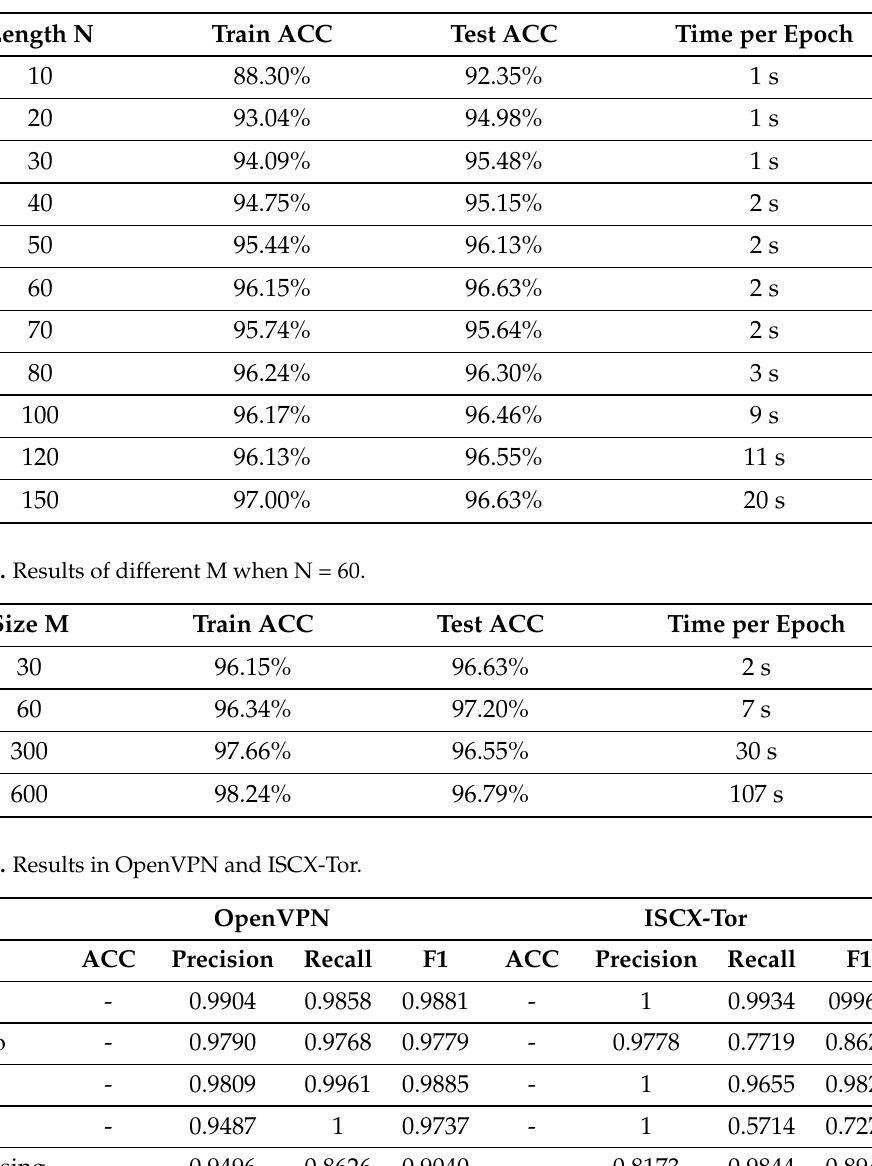
Table 4. Results under different N when M = 30.